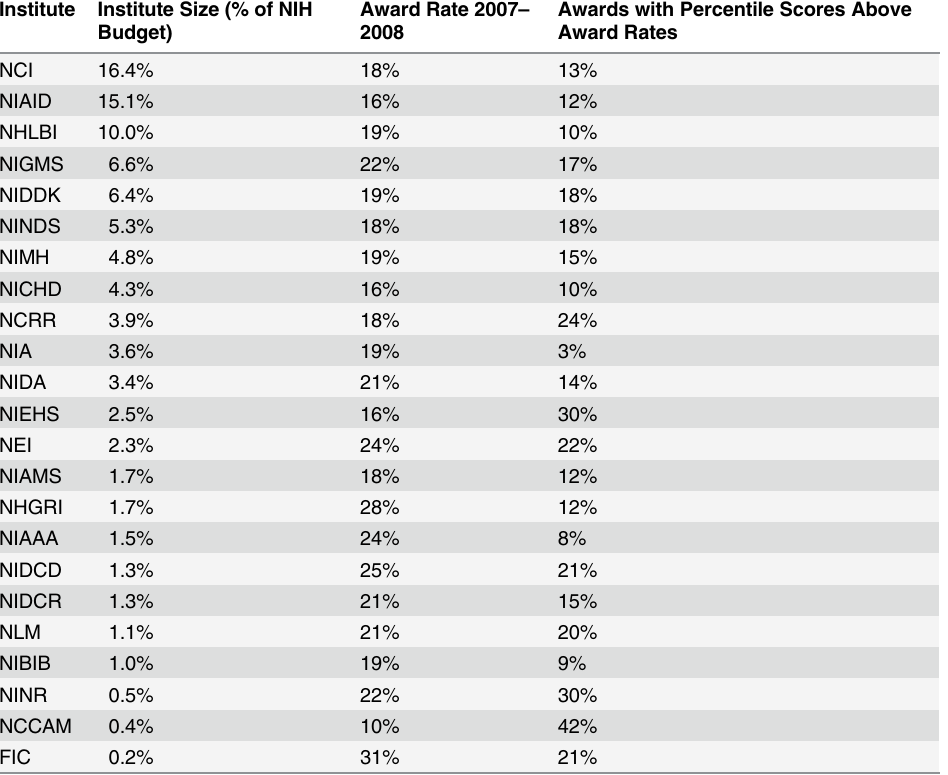
Table 1. New R01s by Funding